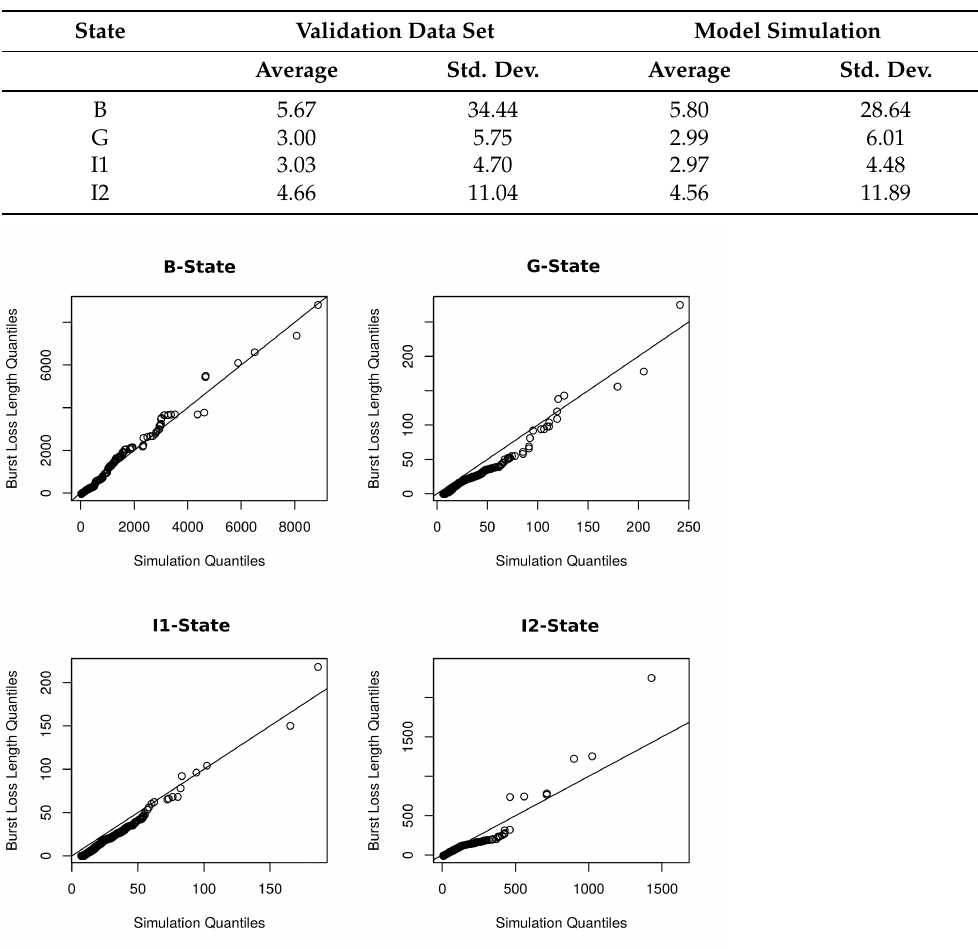
Table 5. BLL of validation set and model simulation.